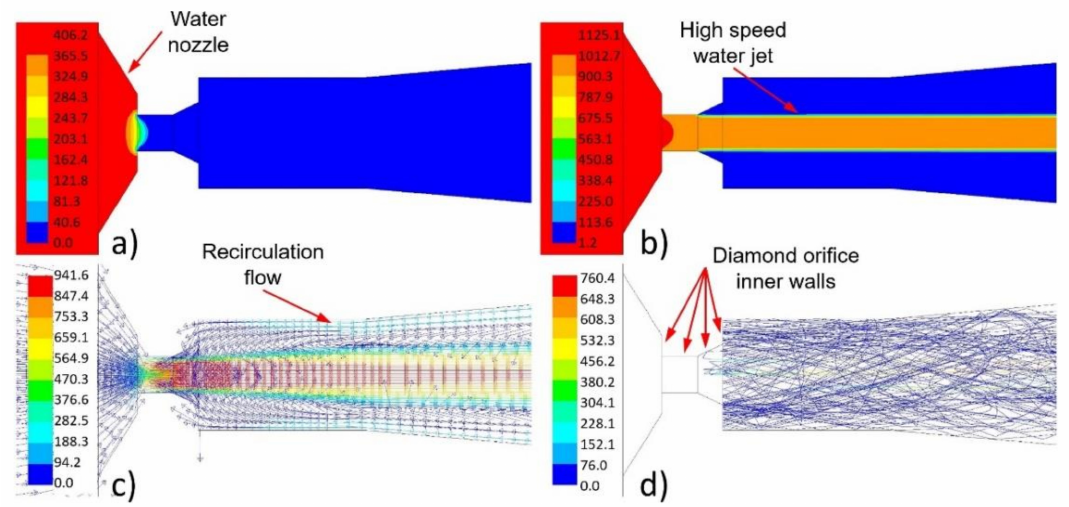
Figure 9. A graphical example of the calculated flow field shape around the water nozzle under the feeding pressure of 406 MPa: ( a ) distribution of the absolute pressure (MPa); ( b ) distribution of the density (kg/m 3 ); ( c ) distribution of the velocity vector (m/s); ( d ) abrasive particle traces coloured by particle velocity magnitude (m/s)—abrasive particle mass flow rate of 100 g/min.